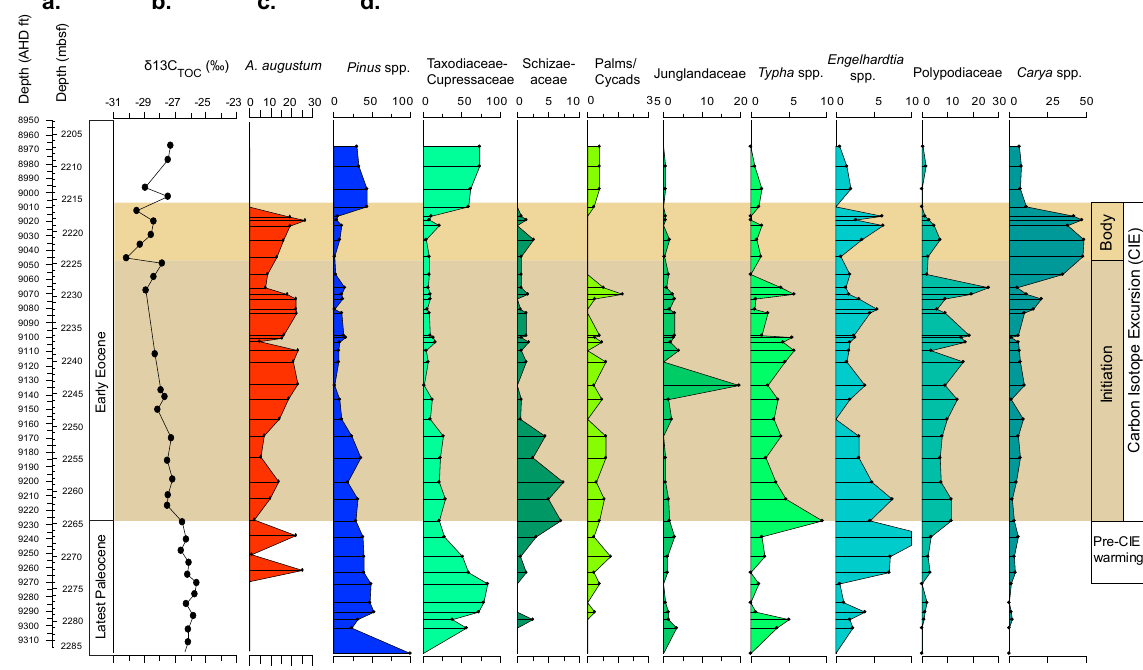
Fig. 3. Data from well 22/11-N1: (a) depth (AHD – along hole depth), (b) carbon isotope data ( δ 13 C TOC ) , (c) distribution and percentage abundance of the dinocyst A. augustm , and (d) selected spore and pollen percentage